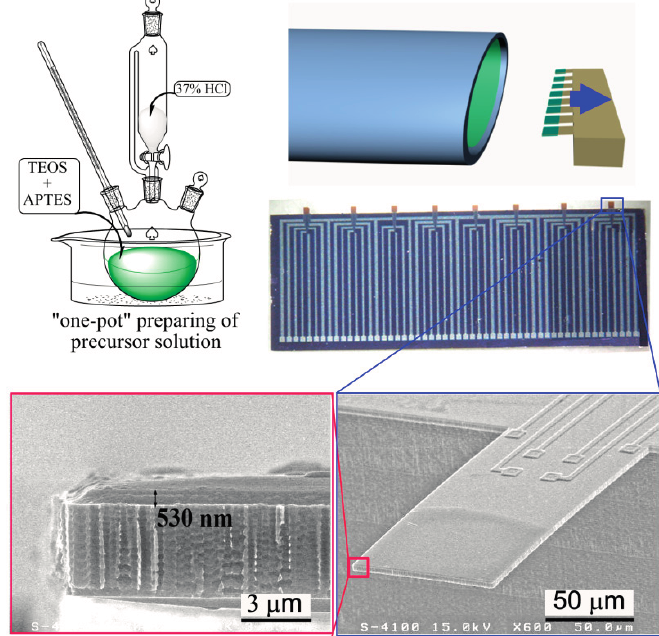
Figure 11. Schematic of − NH 2 functionalized mesoporous thin film (MTF) batch constructed on the cantilevers and the SEM images of the as-functionalized cantilever sensor. Reprinted with permission from [35].